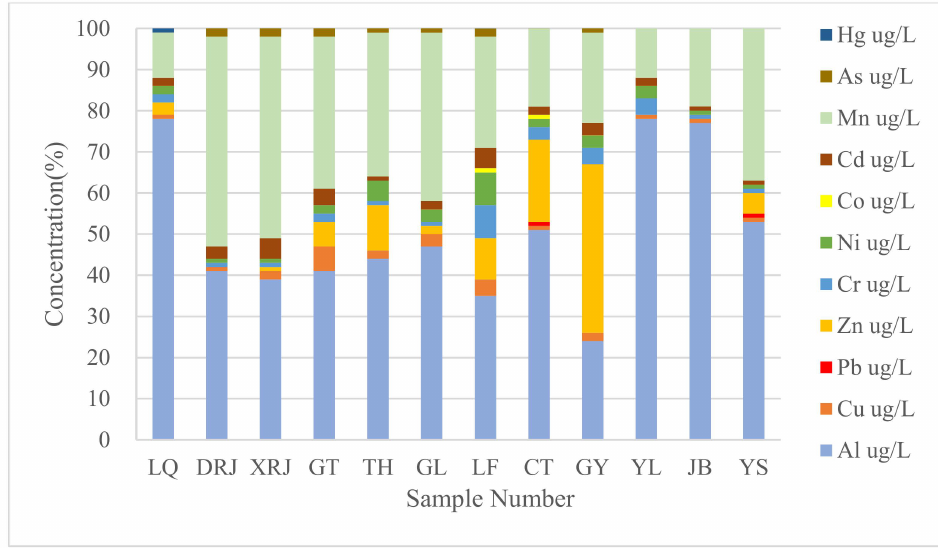
Figure 3. Spatial distribution of heavy metal(loid)s in surface